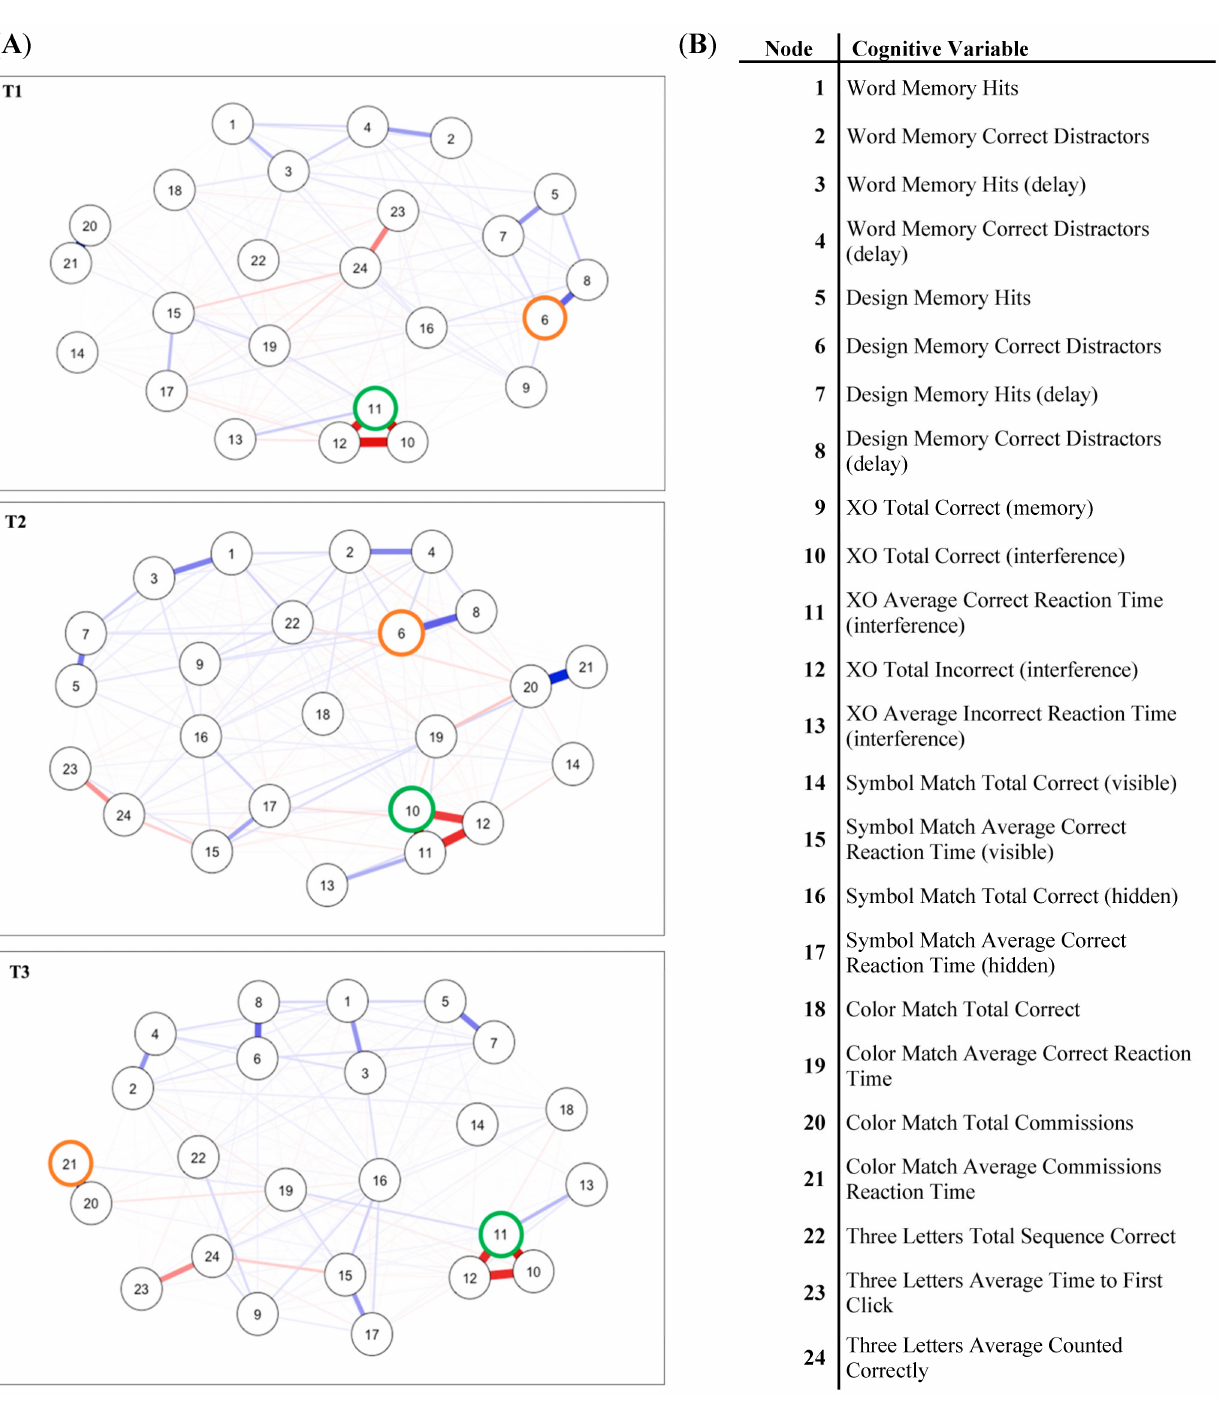
Figure 1. ImPACT Cognitive Subtest Networks and Node Labels. Note. ( A ) T1 (top), T2 (middle), and T3 (bottom) networks with unconstrained layout. (T1 = baseline assessment, T2 = initial administration of ImPACT within 72 h of suspected concussion, T3 = second administration of ImPACT within 14 days of suspected concussion). Highest node strength outlined in green, highest expected influence outlined in orange. ( B ) Node numbers and corresponding variable names for the 24 cognitive